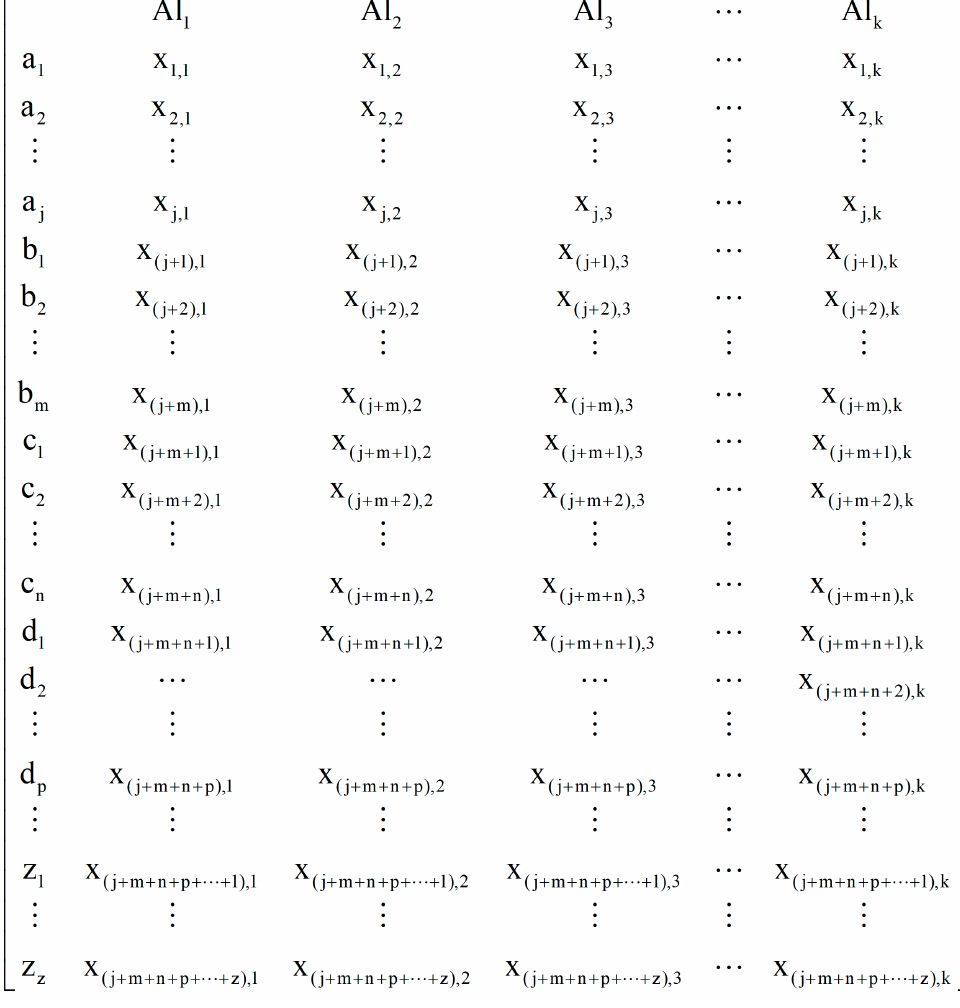
Figure 2. Reduces binary elimination matrix with corresponding submatrices.